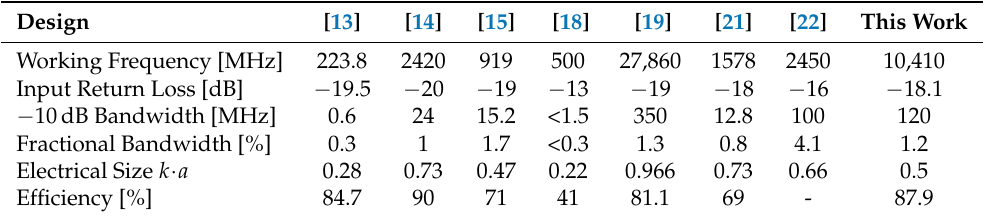
Table 1. Comparison between characteristic parameters of our electrically small antenna with most recent work of other groups. In the cases, where the characteristic parameters were not readily denoted in references [13–15,18,19,21,22], they were indirectly calculated based on the data in the aforementioned